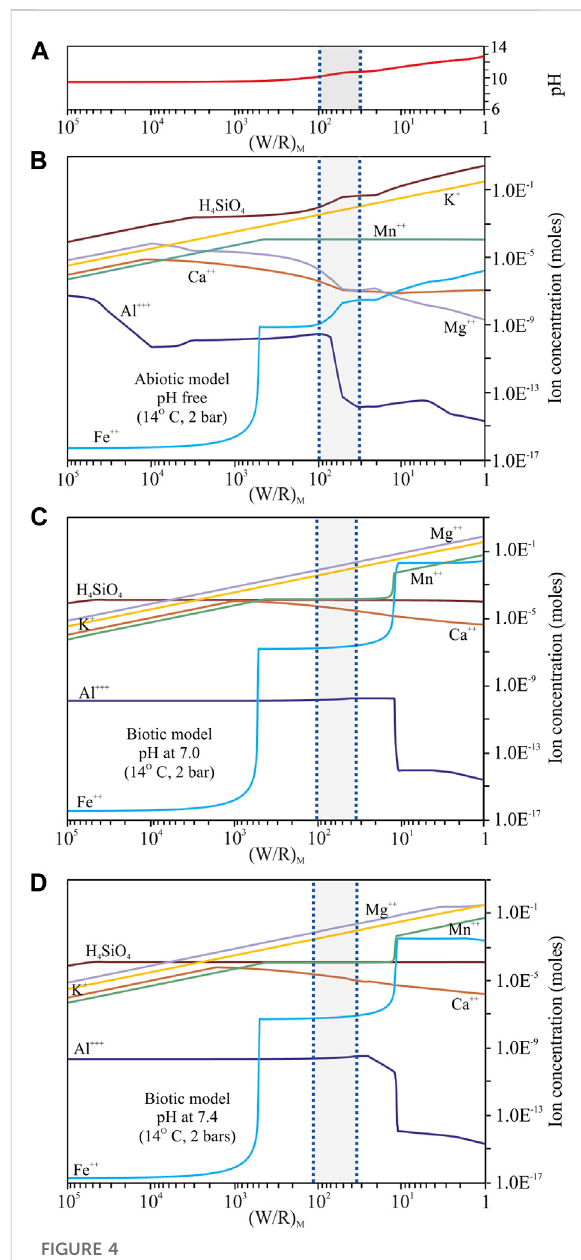
FIGURE 4 Fluid composition predicted from the dissolution of the regolith simulant at 14 ° C and 2 bar. (A) pH variability in the abiotic model; (B) modelwithpHasafreeparameterthatvariesbetween9.5and12.7; (C) model with pH set at 7.0; (D) model with pH set at 7.4. Only elementsrelevantforadirectcomparisonbetweenthemodelsandthe basaltdissolutionexperimentsareshowninthediagrams(H 4 SiO 4 ,Mg 2+ , Mn 2+ , K + , Ca + , Al 3+ , Fe 2+ ). For more details on the variability of the other elements (Cl − , HS − , NH 4 + , Na + , HCO 3 − , HPO 4 ) see supplementary materials A, B, C. The (W/R) D is represented by the shadowed area in between the two blue dotted vertical lines and it was calculated based on the element potassium because it is not incorporated into the microbes and into any of the expected mineral